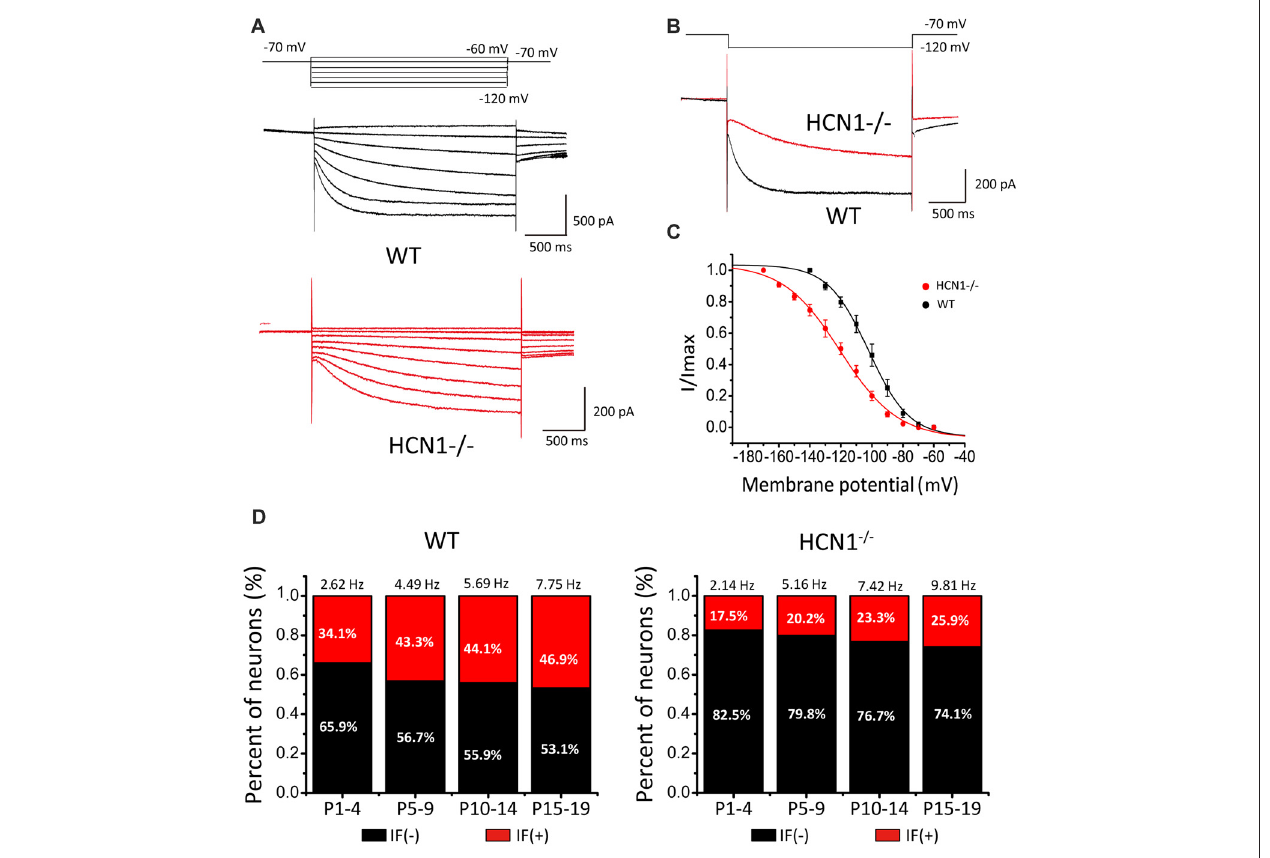
FIGURE 6 | Hyperpolarization- and cyclic nucleotide-gated channel 1 (HCN1) knockout attenuates the amplitude of native I h and IFs in CN neurons. (A) Representative I h recorded from wild-type (WT) and HCN1 deficient mice. The membrane potential was held at − 70 mV before different voltage steps ranging from − 60 mV to − 120 mV (in − 10 mV increment) for 2 s as shown by the protocols above current traces. (B) Comparison of HCN currents evoked at − 120 mV from CN neurons from WT and HCN1 − / − mice showing smaller and slower I h in HCN1 − / − neurons. (C) Activation curve of I h in CN neurons from WT and HCN1 − / − mice, fit with the Boltzmann function. (D) Histograms that showing percentages of IF (+) neurons in different age groups. Numbers above bars are the frequencies of IFs for each age group.